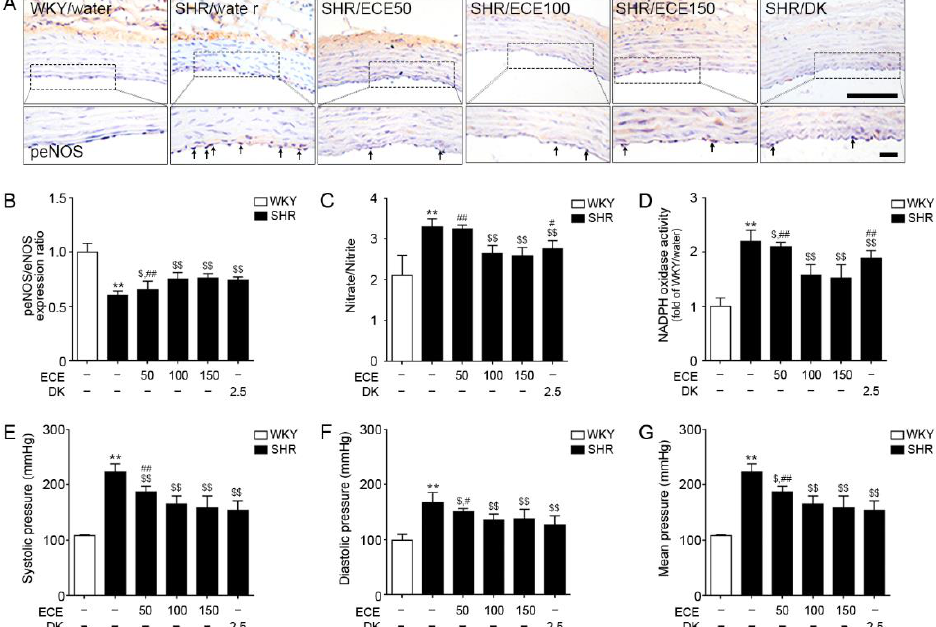
Figure 5. Modulating effects of DK and ECE on endothelial cell dysfunction in the aorta of SHRs. ( A , B ) The peNOS/eNOS expression level in aorta tissue was decreased following SHR/water and increased following ECE or DK treatment. ( C ) The nitrate/nitrite in aorta tissue was increased following SHR/water and decreased following ECE or DK treatment.